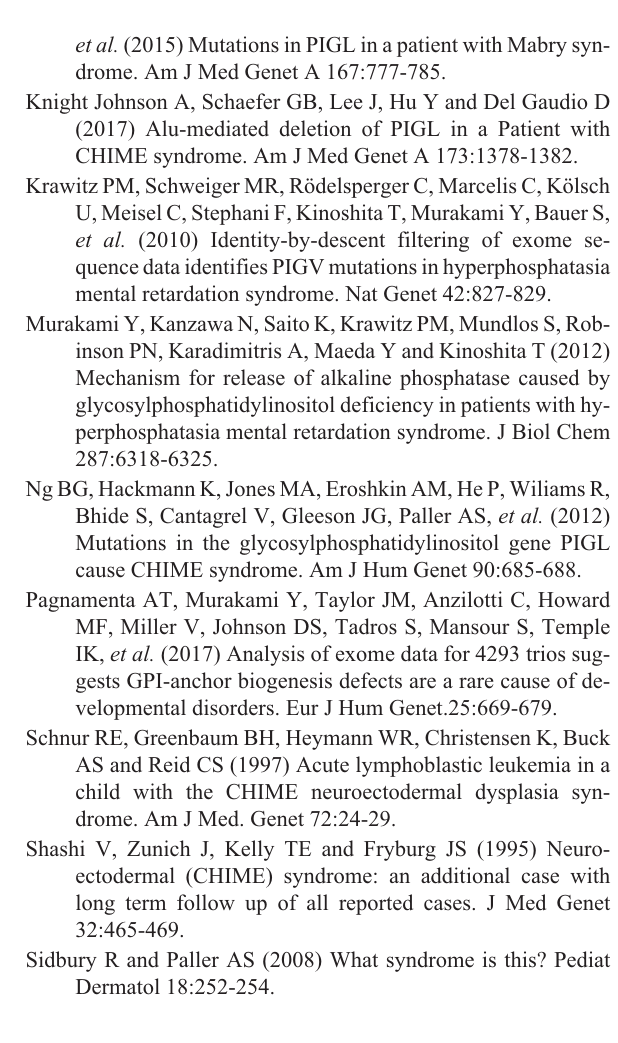
Figure 2 - IGV analysis of PIGL showing a deletion of 802 base pairs ([hg19] chr7: 16,119,889-16,120,690) involving the 5’ untranslated region and the first 50 aminoacids, including the ATG start codon in exon